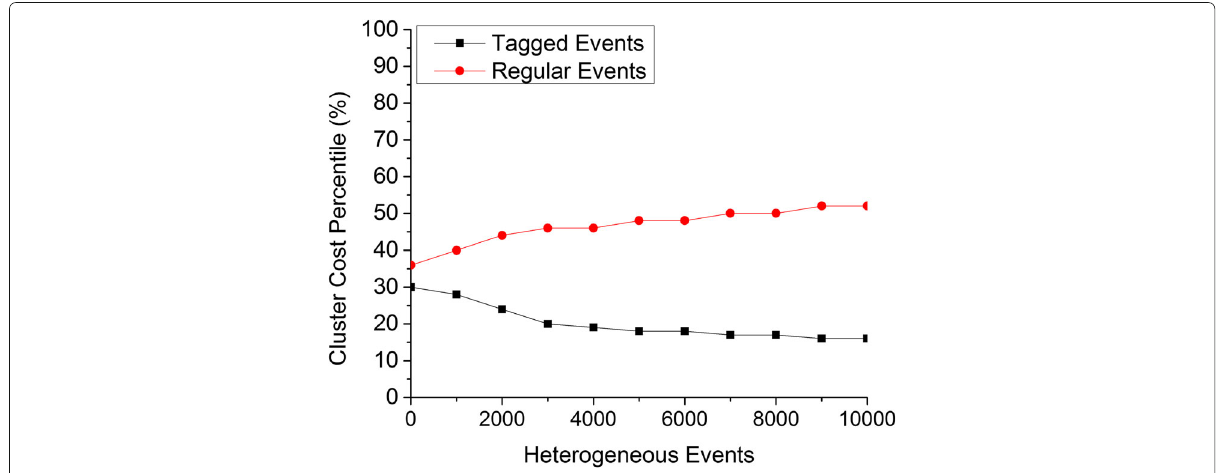
Fig. 11 Heterogeneous Event Processing on Spark